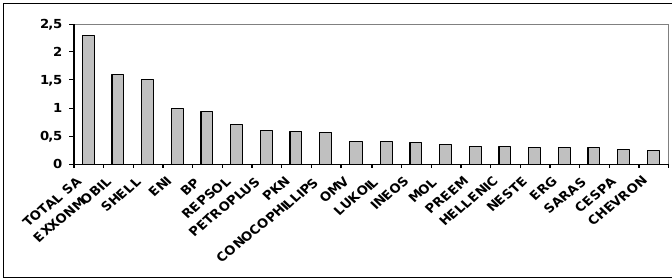
Figure 5: Refinery Players in Europe by Refinery Capacity (mb/cd) 9 –